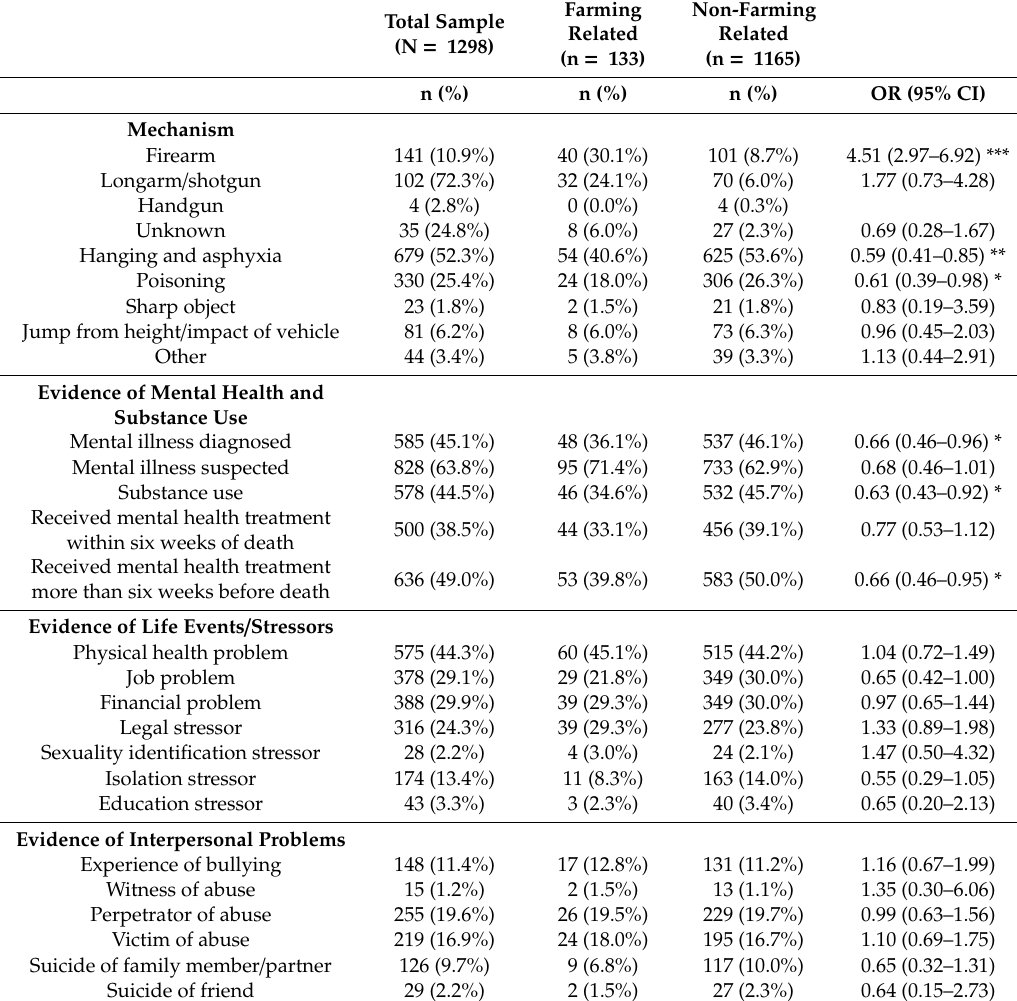
Table 2. Mechanism and Circumstances of Farming-Related and Non-Farming-Related Suicide